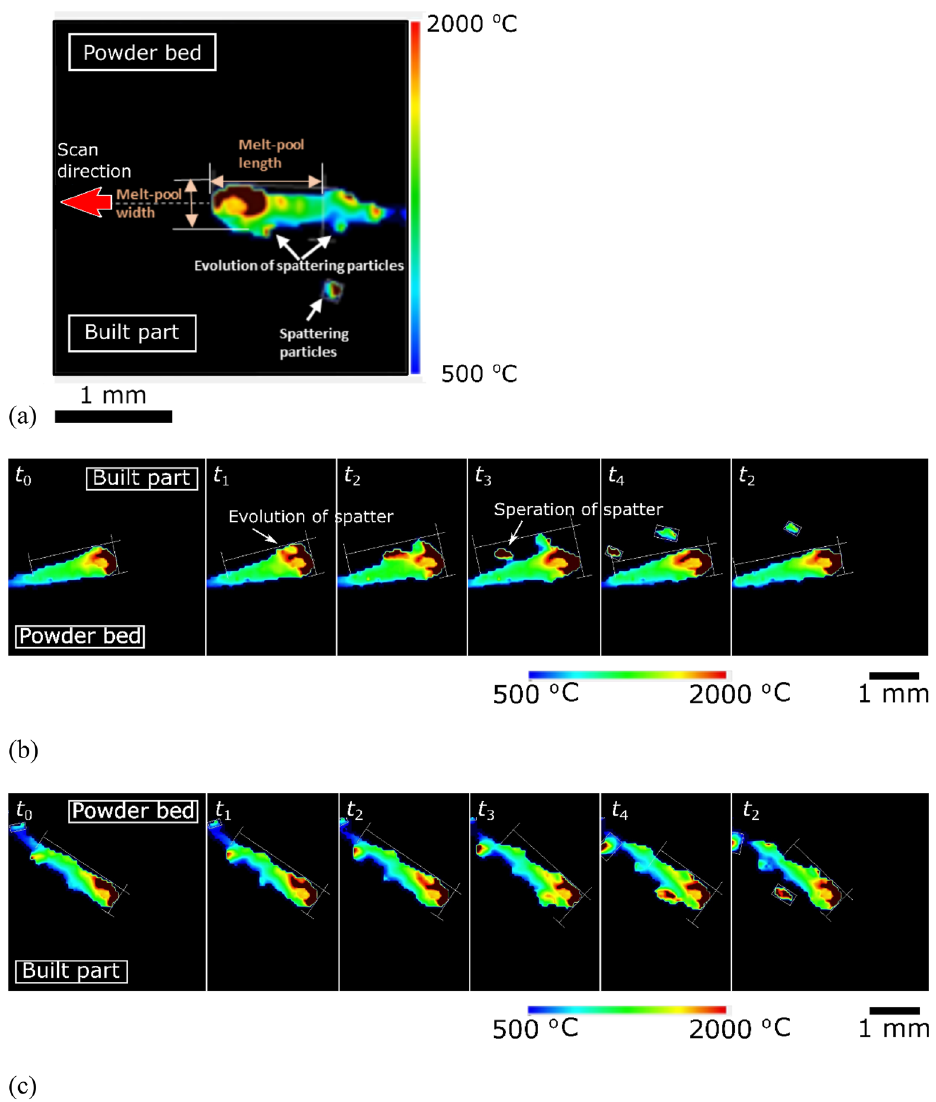
Figure 3. Images of a melt pool captured by the monitoring apparatus. ( a ) Representative morphology of the melt pool. ( b ) Sequential images of the melt pool behavior on a surface with a relatively lower 2 σ value of the 1250th layer of the built specimen fabricated at the conditions ( P = 200 W, v = 665 mm/s, h = 0.1 mm, z = 0.05 mm, and E = 30.1 J/mm 3 ). ( c ) Sequential images of the melt pool behavior on a relatively rough surface